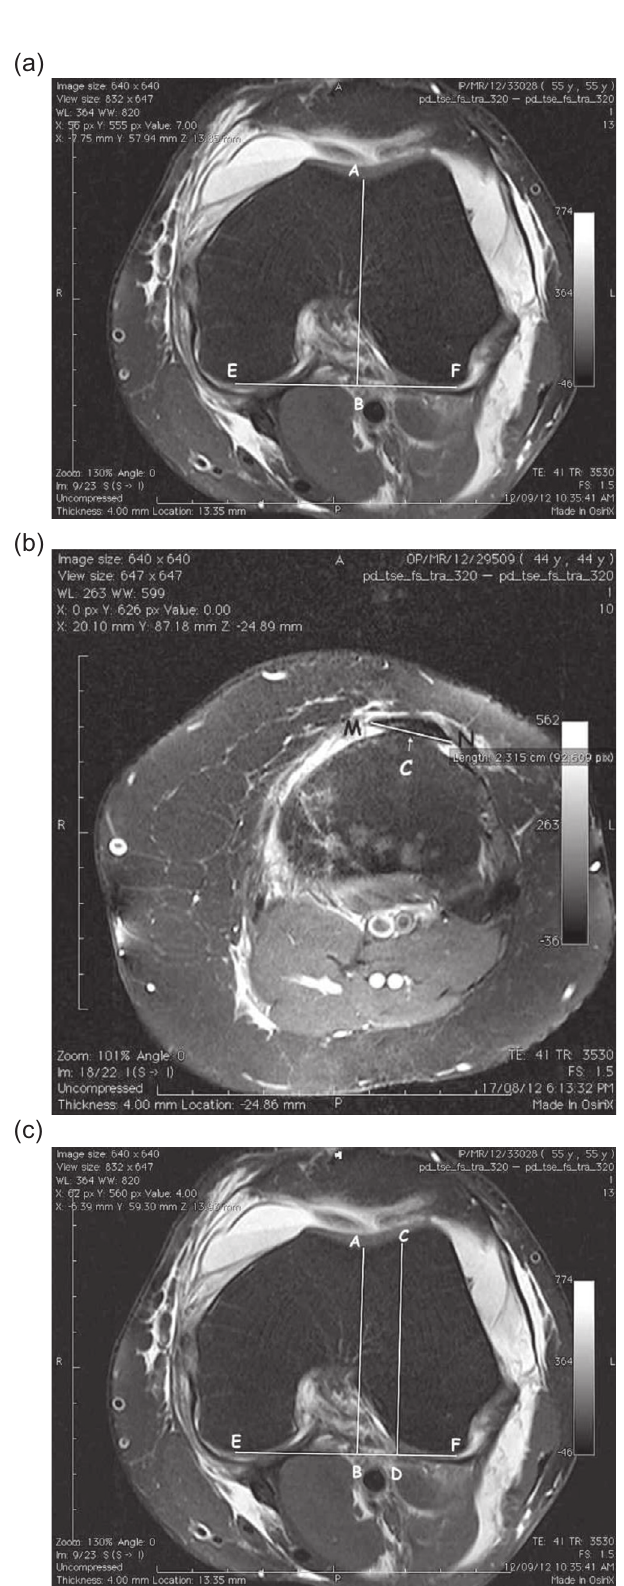
Figure 1. Measurement of TTTG distance using OsiriX software. image a posterior condylar line (Line EF) is drawn. A perpen- dicular line is drawn from the deepest point of the trochlear